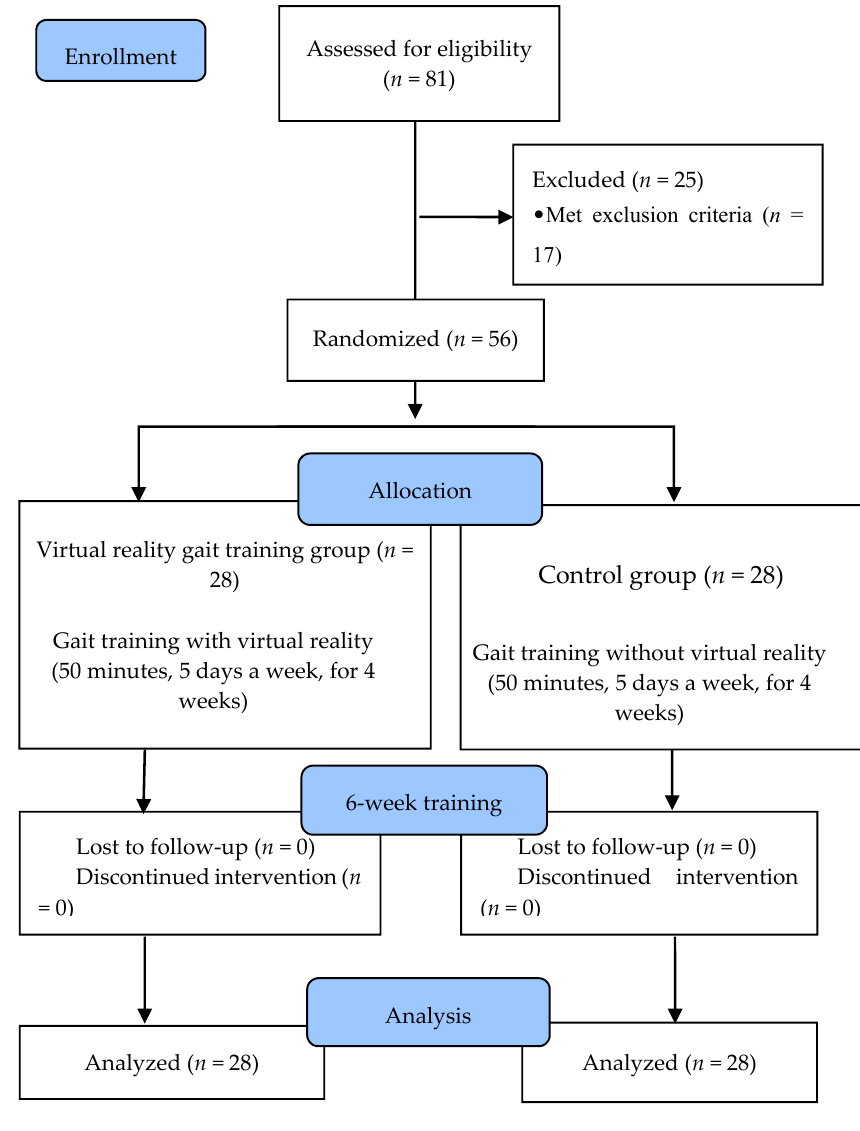
Figure 1. Flow diagram of the study.